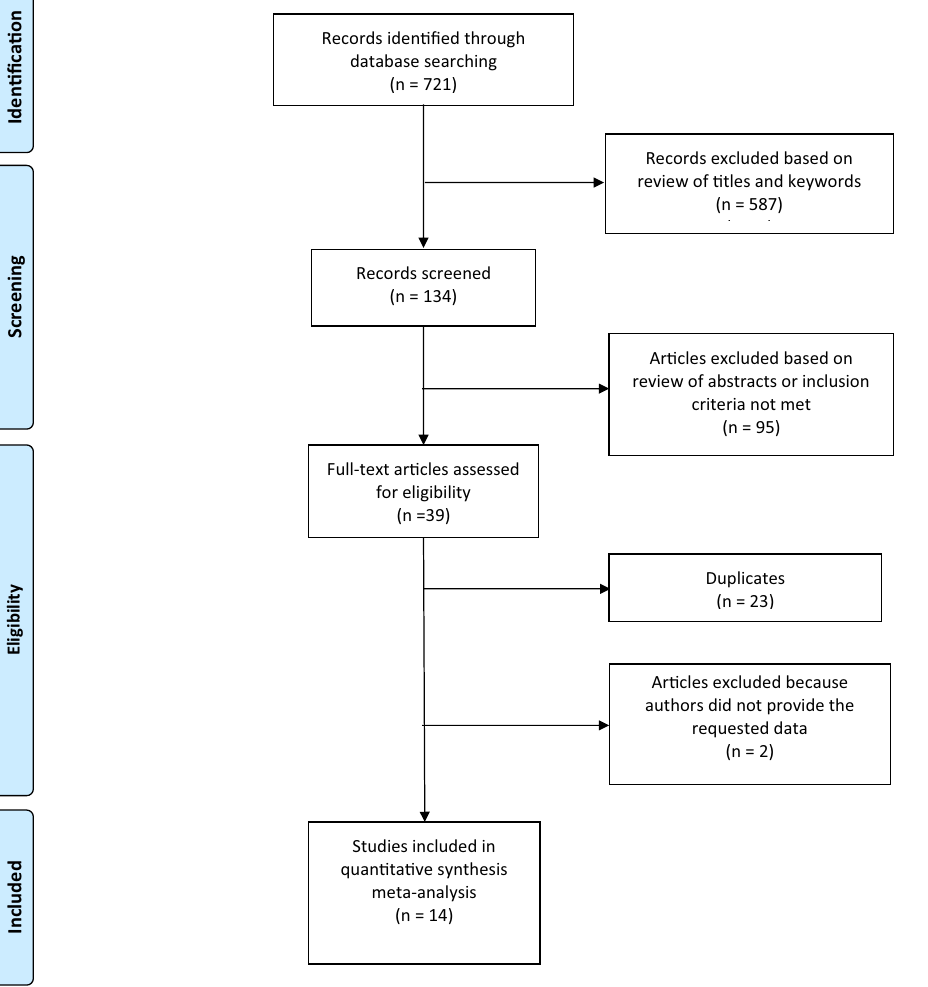
Figure 1. Flowchart illustrating study selection, review strategy and data